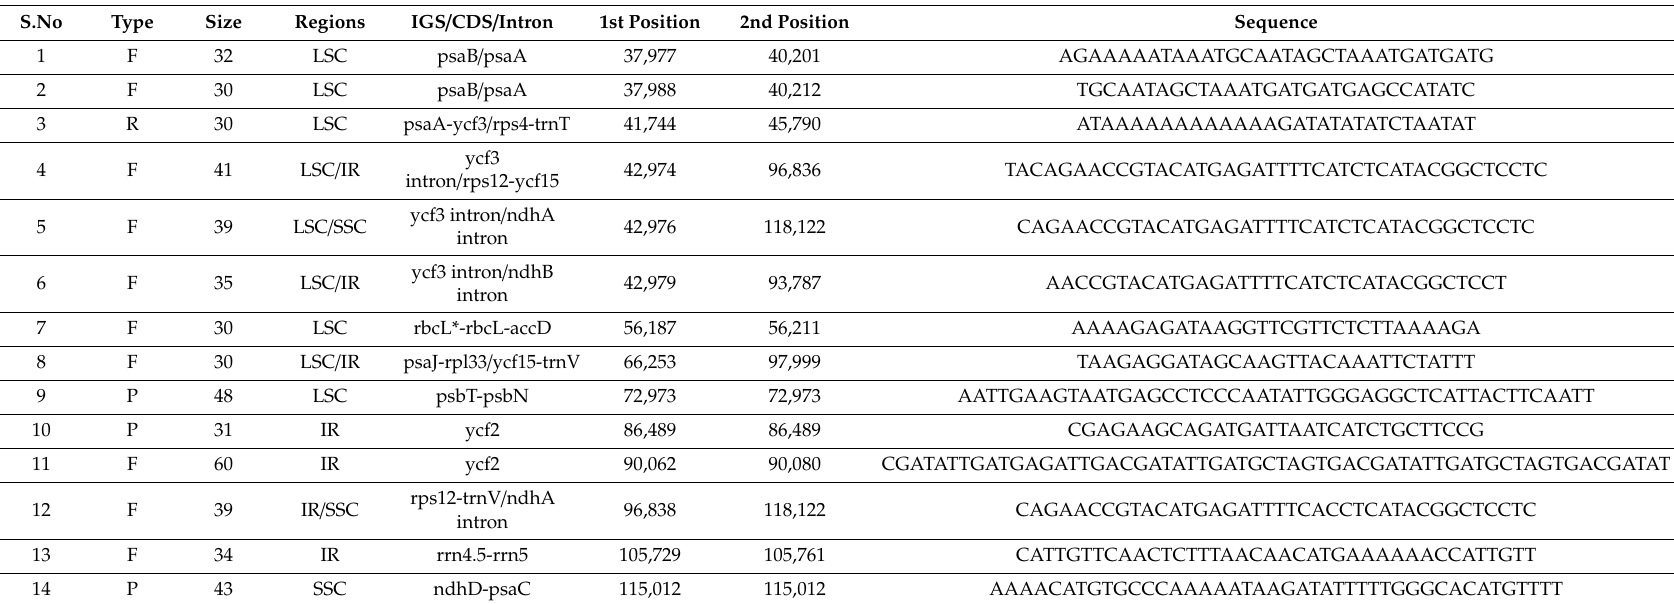
Table 3. Oligonucleotide repeats in Artemisia scoparia